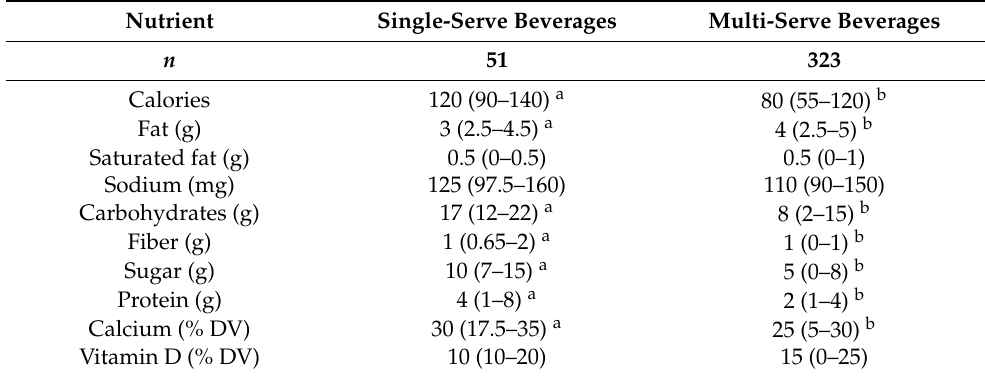
Table 4. Median (Q1–Q3) values for nutrients in single-serve non-dairy beverages contrasted with that of one serving of multi-serve non-dairy